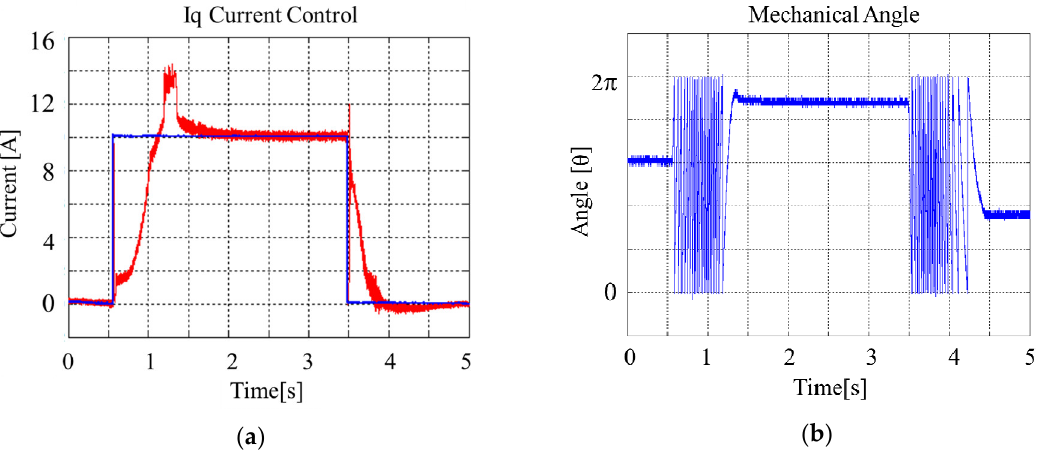
Figure 15. EMB test results: ( a ) Iq axis current control; ( b ) mechanical rotation angle.